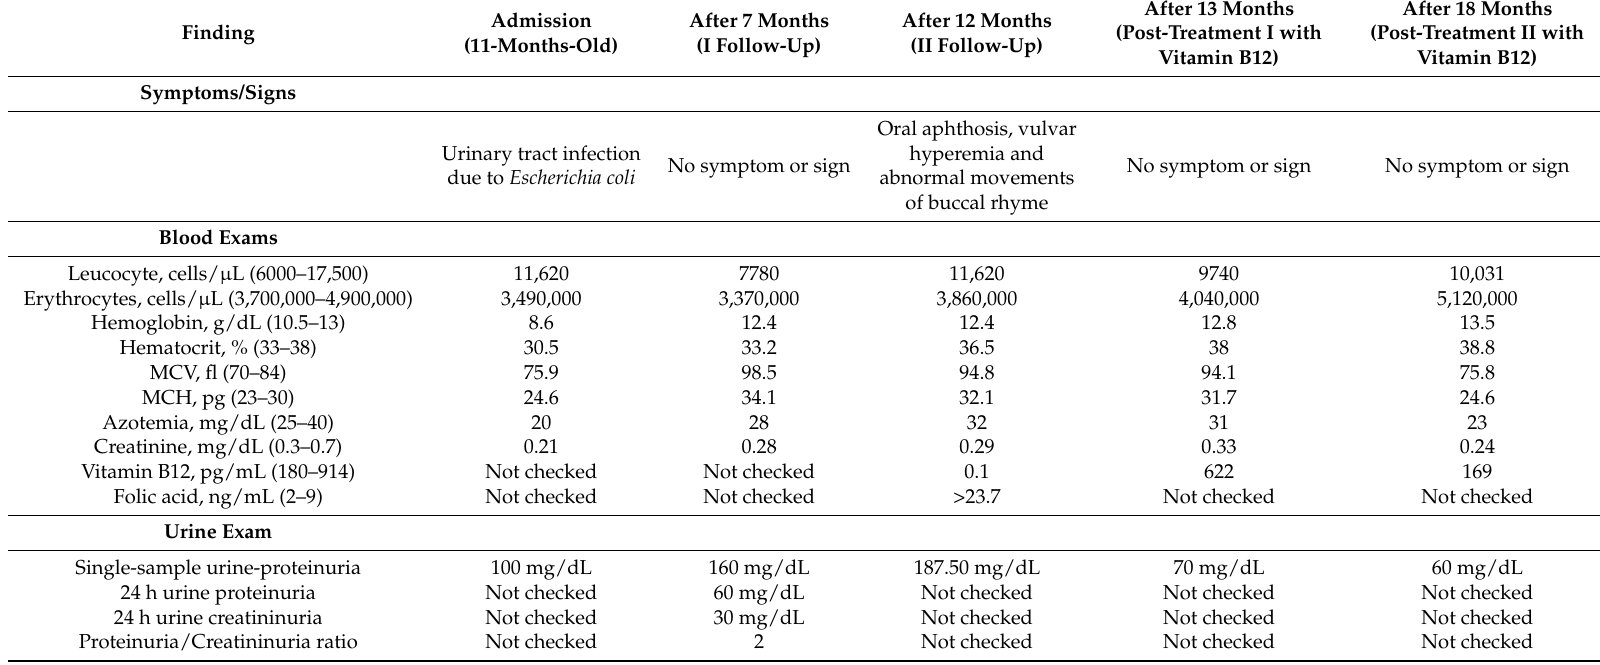
Table 1. Clinical and laboratory findings at admission and during the